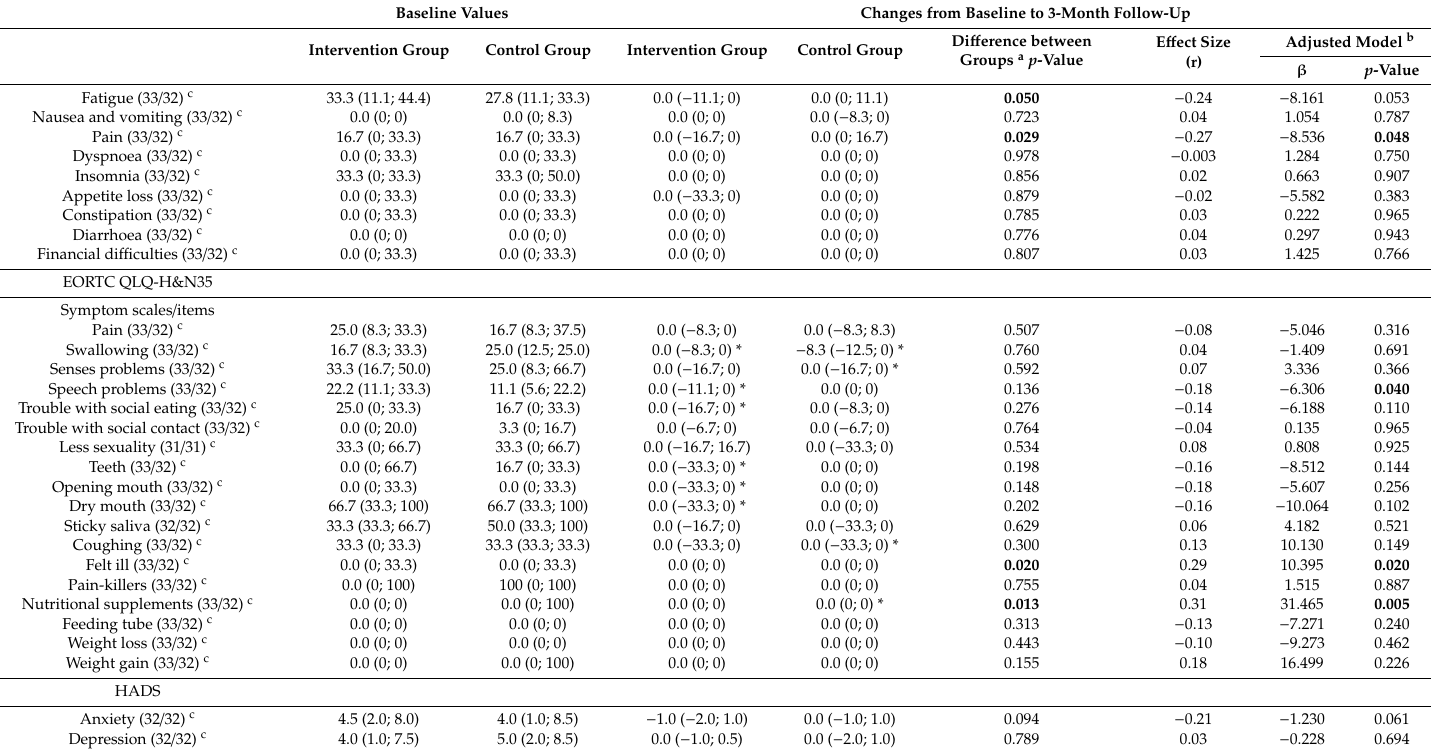
EORTC: European Organization for Research and Treatment of Cancer, HADS: Hospital anxiety and depression Scale. Baseline values and changes within groups are shown as medians and quartiles (Q1; Q3). Significant p -values are highlighted in bold. The EQ-5D-5L VAS ranges from 0–100, and the summary index calculated based on Danish values ranges from − 0.624 to 1.0. A higher score indicates better self-rated health. The EORTC QLQ-C30 and QLQ-H&N35 scales range from 0–100. A higher score indicates a higher response level. Thus, a high score for a functional scale or global QOL indicates a high level of functioning / QOL and a high score on a symptom scale indicates a high symptom level. The HADS subscales range from 0–21, and a higher score indicates a higher symptom level. a Di ff erences between groups are tested with the Mann–Whitney U test. b Di ff erences between groups assessed in a multiple linear regression model including gender, time interval (months) posttreatment, and rehabilitation needs assessed by the REHPA scale. c n included in analyses in (intervention / control) groups. * Statistically significant change ( p < 0.05) within group from baseline to 3-month follow-up tested with the Wilcoxon signed-rank test. Results are shown in Appendix B, Table